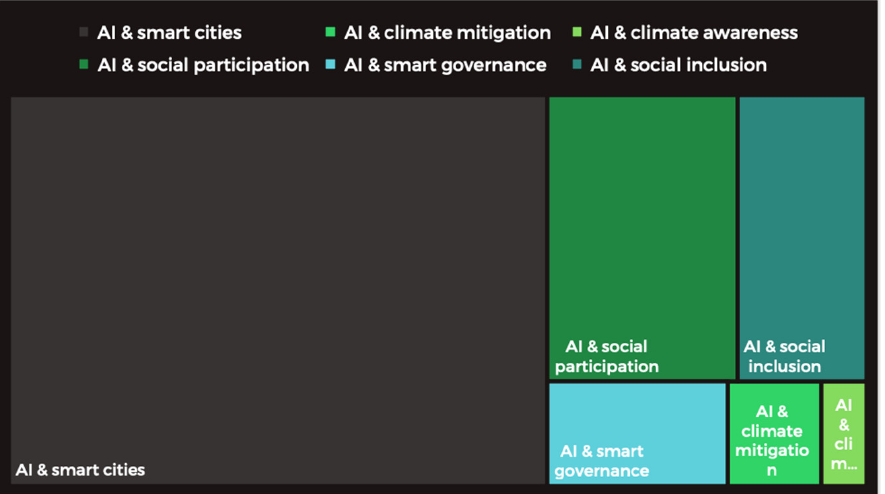
Figure 2. Research gap presenting the limited number of climate-related papers embedded in smart city concepts employing AI. Authors’ own elaboration based on Scopus keywords search.